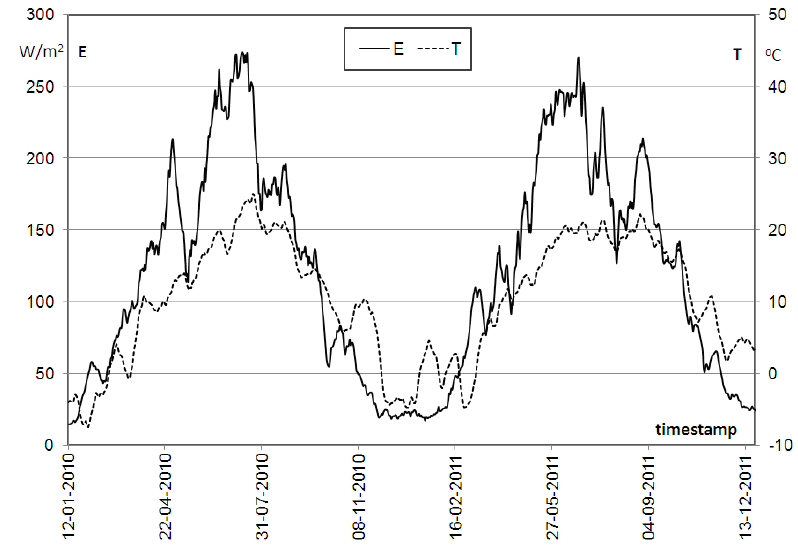
Figure 14. Mean value (for two weeks) of the solar irradiance E and temperature T versus time. The plots of E(t) and T(t) represent rolling means for 14 day-long periods. One can notice that